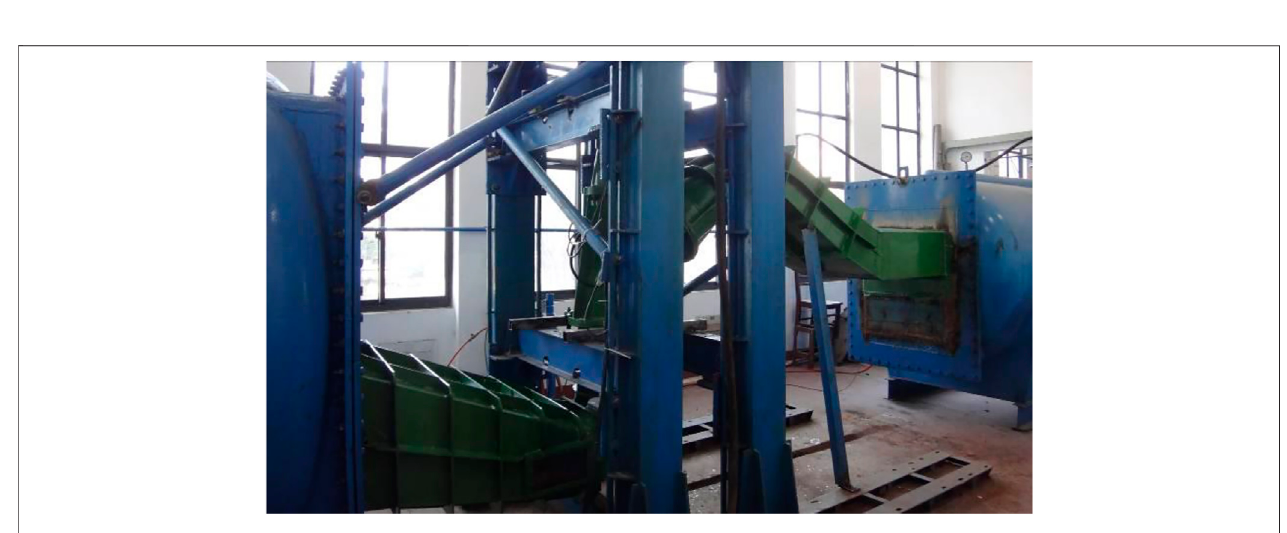
FIGURE 9 | Image of vertical axial fl ow pump device model.